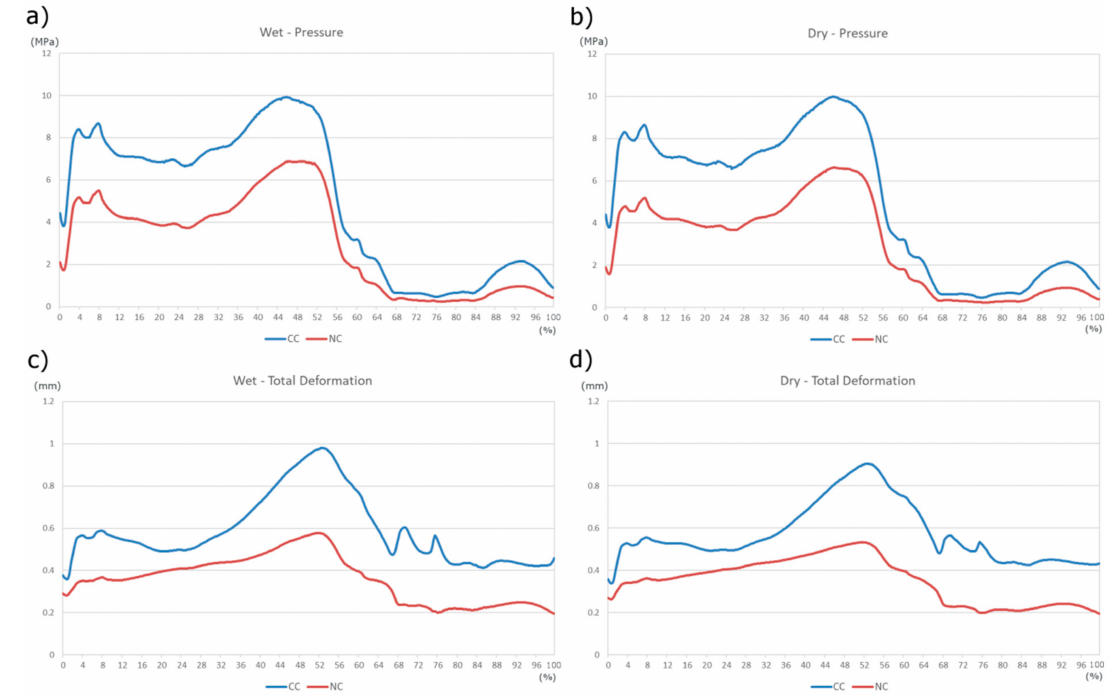
Figure 7. Comparison of result in the wet ( a , b ) and dry ( c , d ) condition, between the CC and NC